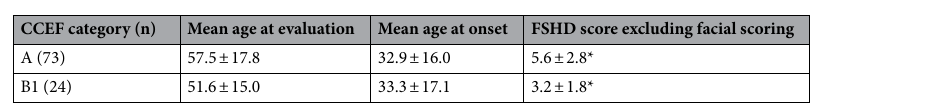
Table 2. Index cases with typical (category A) and facial-sparing (category B1) phenotype. * p < 0.001.